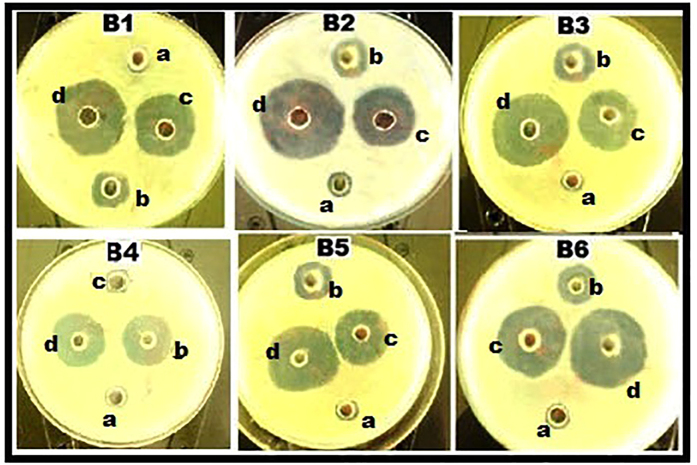
Petri plates showing the ZOI of SNPs, topical antibiotic and combinations against P. aeruginosa.B1: Cefazolin; B2: Mupirocin; B3: Gentamycin; B4: Neomycin; B5: Tetracycline; B6: Vancomycin. a: Control; b: SNP; c: Topical antibiotic; d: SNP + Topical antibiotic.